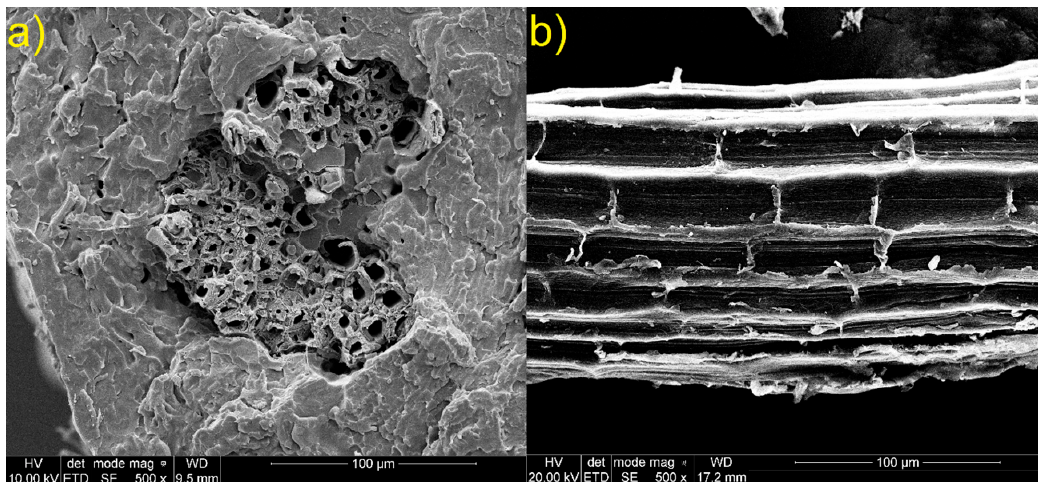
Figure 13. Tan δ values of obtained hybrids.